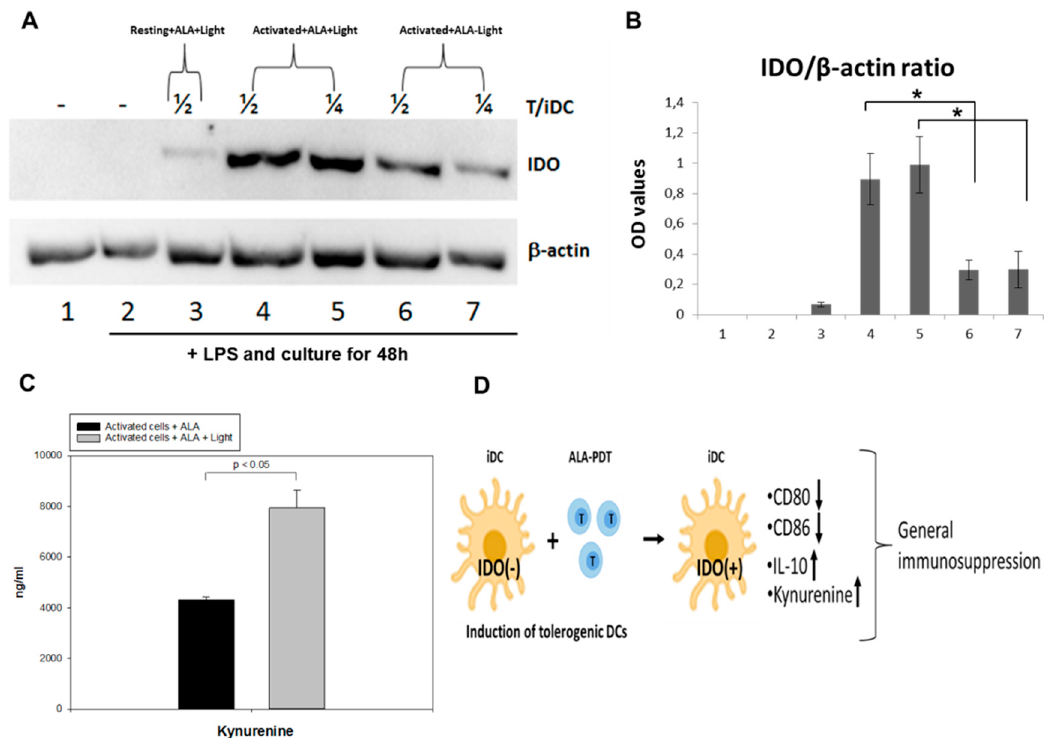
Figure 10. ALA-PDT treated T cells induce expression of IDO. ( A ) monocyte-derived immature DCs were incubated with control or PDT-treated autologous CD4 + T cells at a ratio of 1/2 (4 & 6) or 1/4 (5 & 7) (as indicated) overnight and then stimulated with LPS (50 ng/mL) for further 48 h. The IDO expression was analyzed by Western immunoblotting. Data is a representative of three independent experiments; ( B ) normalized OD values of IDO expression with β -actin; ( C ) the Kynurenine contents in the supernatants of activated cells treated with ALA alone or plus light were measured with ELISA; ( D ) a simple schematic illustration of the suggested mechanism on how ALA-PDT mediated over-expressed IDO in iDCs induces an immune-suppressive effect with the downregulation of CD80 and CD86 and increased expression of IL-10 and Kynurenine.